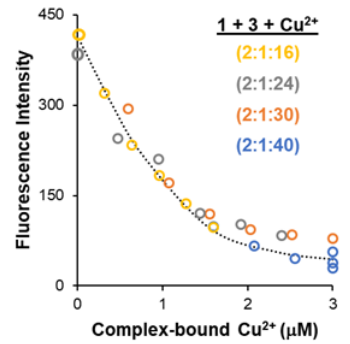
Figure 4. Superposition of CN − dose response curves from Figure 3a, obtained by plotting fluorescence ( λ EX = 350 nm; λ EM = 430 nm) as function of bound Cu 2 + within the ternary ( 1 + 3 + Cu 2 + ) complex; the dotted line represents the expected fluorescence response upon Cu 2 + removal from the ternary complexes. We assume that CN − -induced Cu 2 + displacement from 1 + 3 + Cu 2 + complexes involves formation of [Cu(CN) x ] 1 − x complexes; x = 4 (blue, orange and gray circles) and 6 (yellow circles).